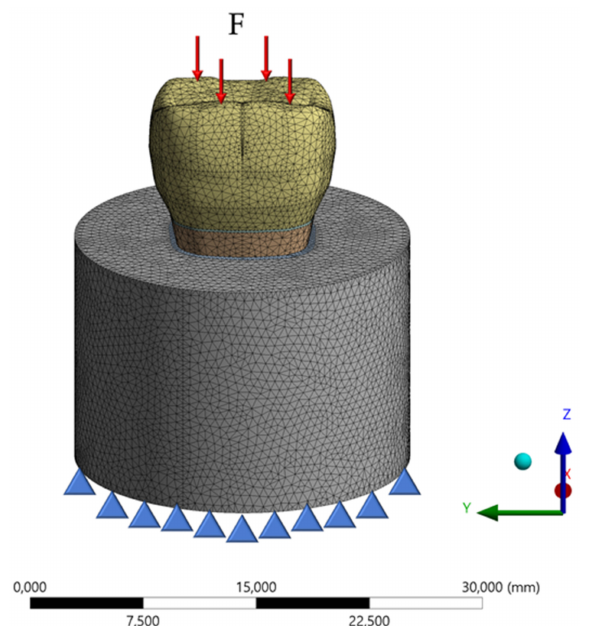
Figure 3. Finite element model after meshing process and boundary conditions applied in the